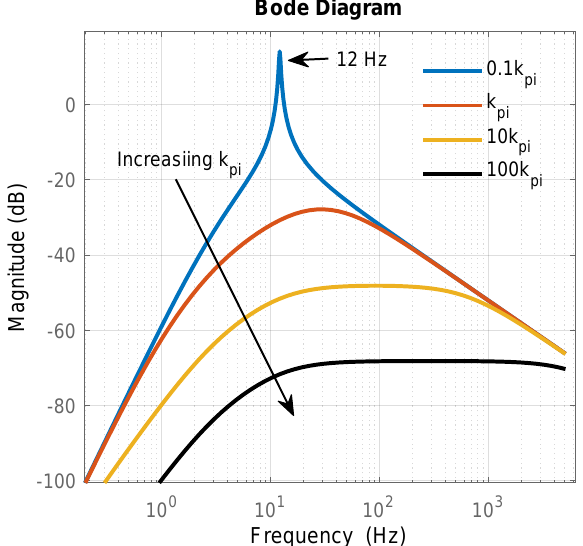
Figure 15. Sensitivity of output admittance Y oc , v to k pi in increasing order of 0.1 × , 1 × , 10 × , and 100 × k pi (base